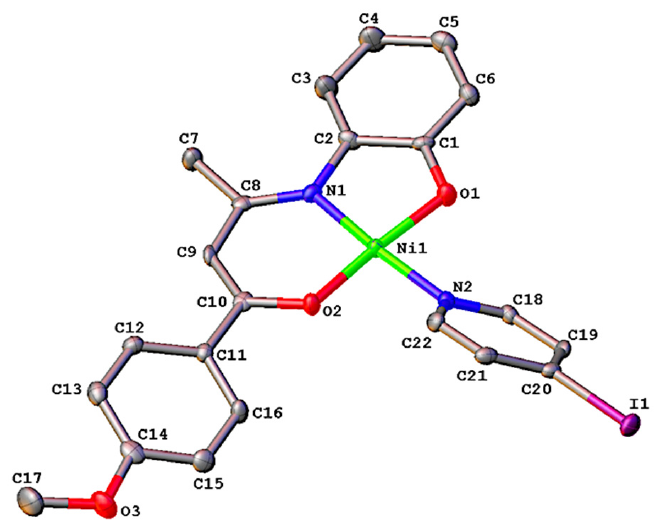
Figure 2. Molecular structure of complex 6 with labelling scheme for selected atoms. Hydrogens have been omitted for clarity. Thermal ellipsoids are drawn at the 50% probability level.